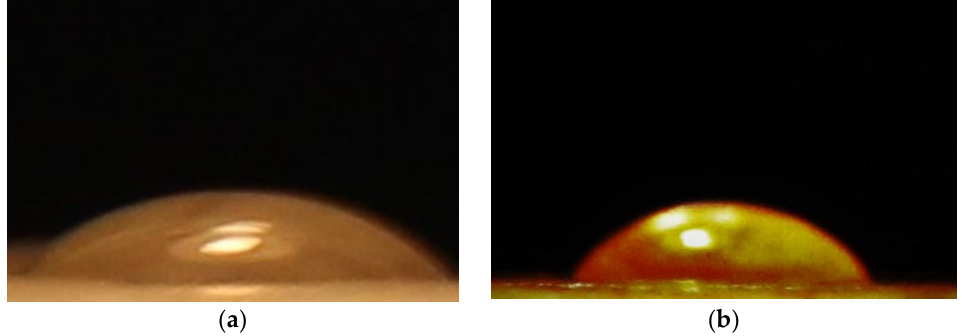
Figure 6. The contact angle images for fabricated biocomposites (( a ) PLA and ( b ) PLA ‐ WL ‐